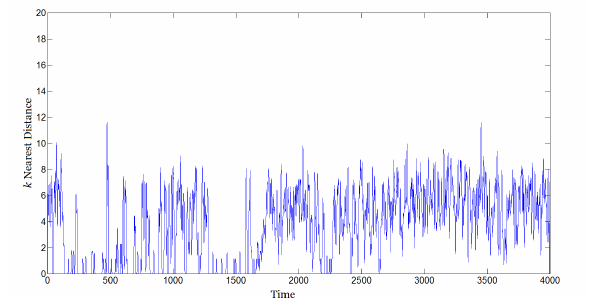
Figure 2. k Nearest Distance of Training Data.